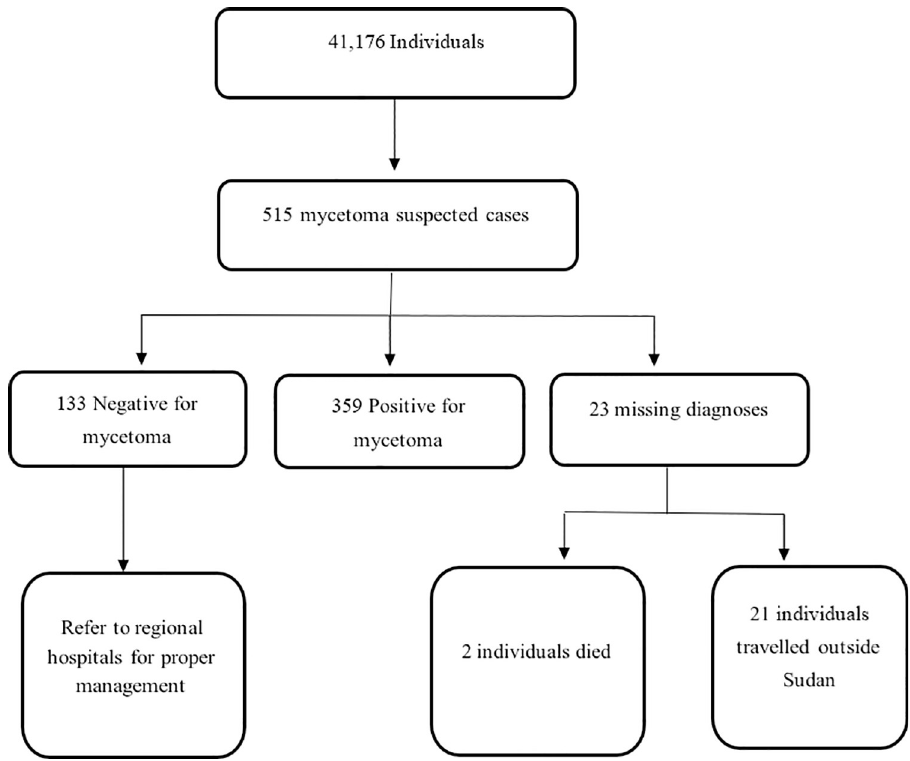
Fig 2. Flow diagram of the total population covered in the survey and the suspected cases identified after clinical examination. It also describes the category of the patients after ultrasound examination.